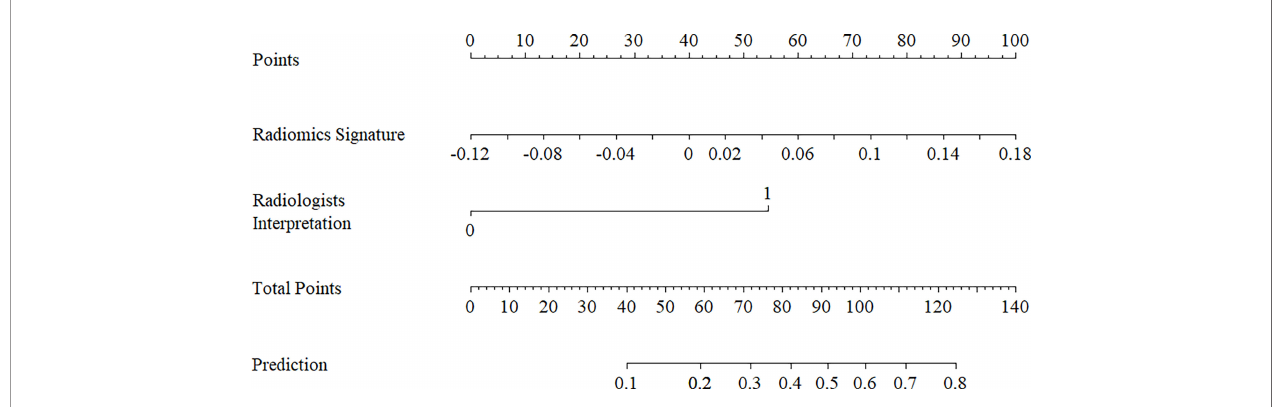
FIGURE 4 | Radiomics nomogram with radiomics signature (rad-score) and radiologists ’ interpretation incorporated.